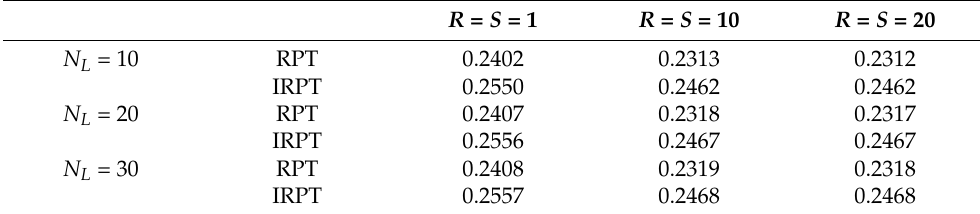
Table 1. Dimensionless central deflection values of Al/ ( ZrO 2 ) -1 functionally graded square plates at different truncation levels. ( n = 0.5).